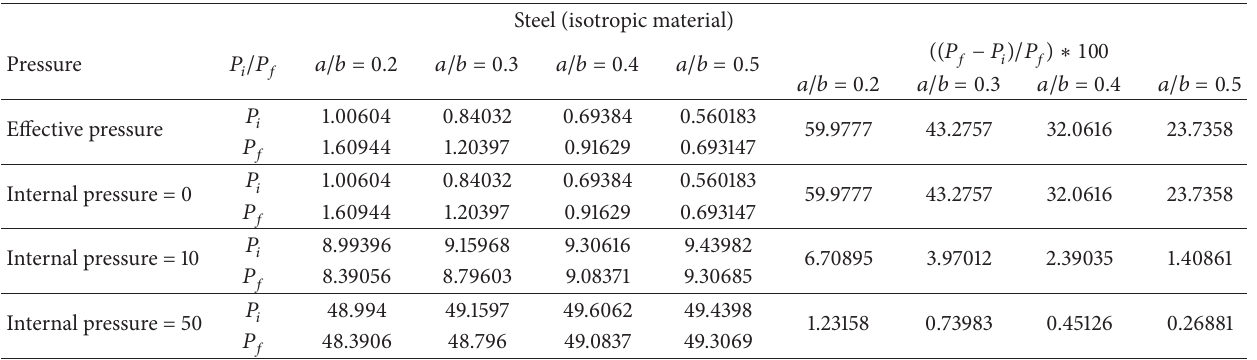
Table 2: The pressure required for initial yielding and fully plastic state for isotropic material (steel).